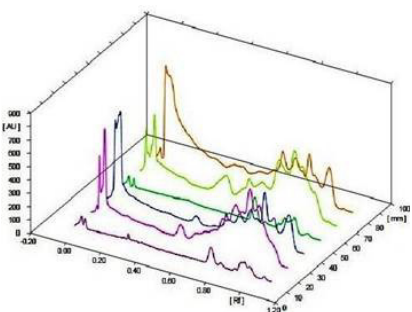
Fig. 14. Maceration fruit extract, HPTLC chromatogram of hexane fruit extract of M. cymbalaria